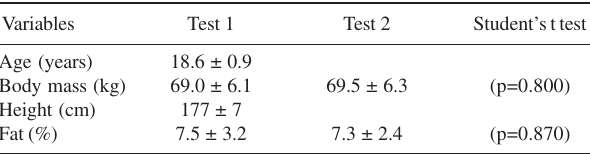
Table 1 – Mean values and standard deviations for age, height, body mass and fat percentage among the soccer players who underwent two ergospirometric tests with a 15- day interval between them, using the modified Heck protocol (n =